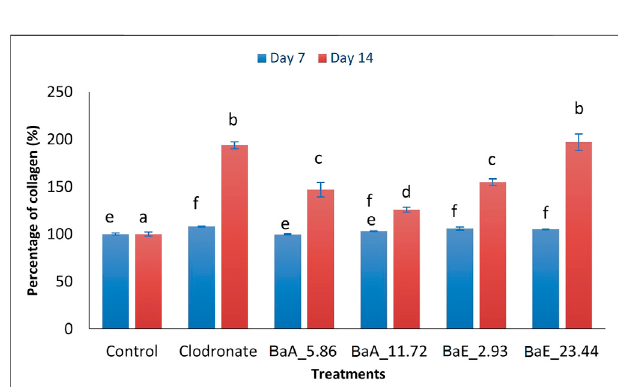
FIGURE 6 | Percentage of collagen in B. acmella aqueous ( Ba A) and ethanol ( Ba E) extracts. Control (untreated cells), Positive control (Clodronate), BaE_2.93 ( Ba E at 2.93 µg/ml), BaE_23.44 ( Ba E at 23.44 µg/ml), BaA_5.86 ( Ba A at 5.86 µg/ml) and BaA_11.72 ( Ba A at 11.72 µg/ml). Different alphabet shows signi fi cant different ( p < 0.05) between treatments in a same day. The data are presented as mean ± SEM ( n (cid:2)